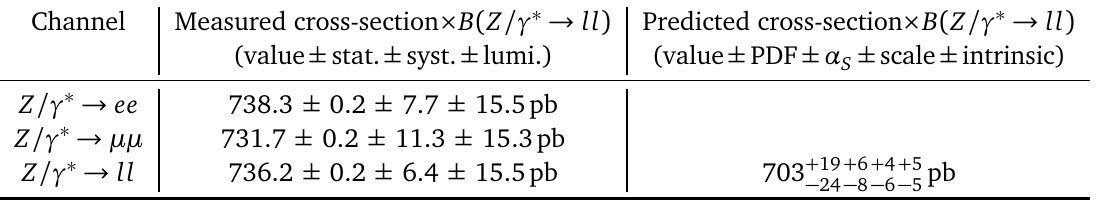
and (b) Φ ∗ distributions predicted by var- η T